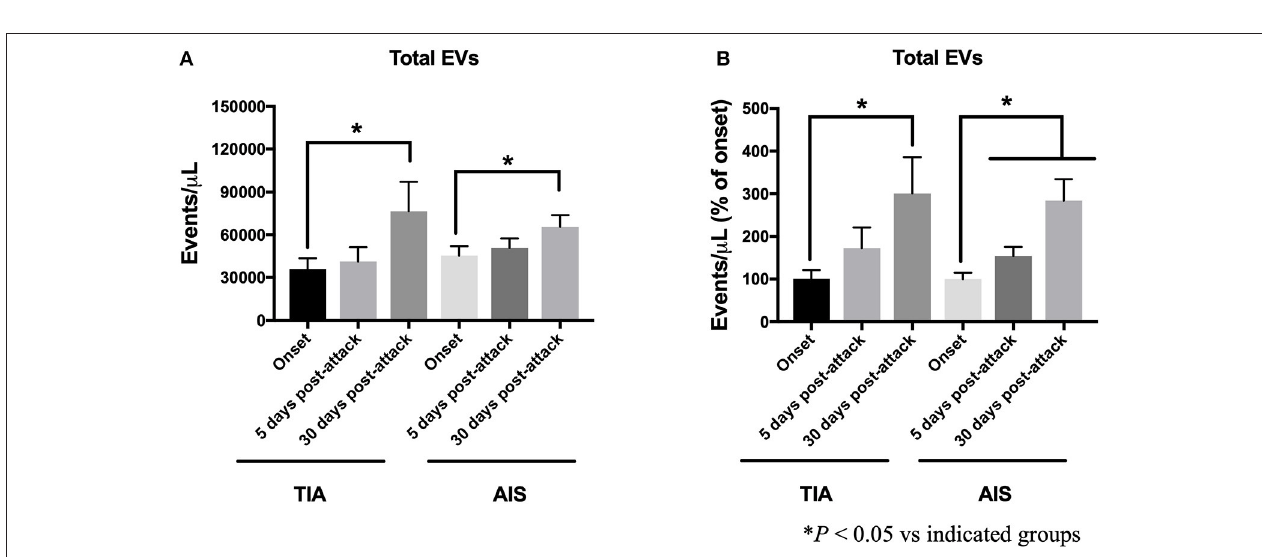
FIGURE 3 | Circulating total EV levels, at onset, 5-days and 30-days post-attacks in patients with TIA and AIS patients. (A) Histograms represent total EVs expressed as events/ µ L in PFP. (B) Histograms represent total EVs expressed as events/ µ L (% of onset levels) in PFP. Data are expressed as mean ± SEM. Controls, n = 24; TIA, n = 21; AIS, n = 66. * P < 0.05 vs. indicated